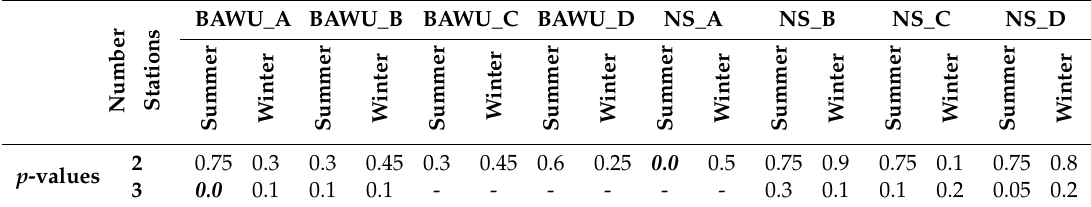
Table 4. Goodness of fit of Vine copula models as p -values for different seasons and case studies.